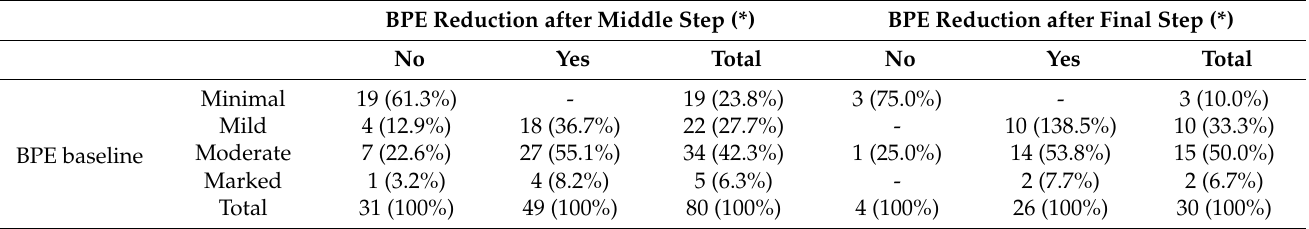
Table 5. Baseline BPE reduction distribution compared to BPE reduction after 1st-step and 2st-step NAC.